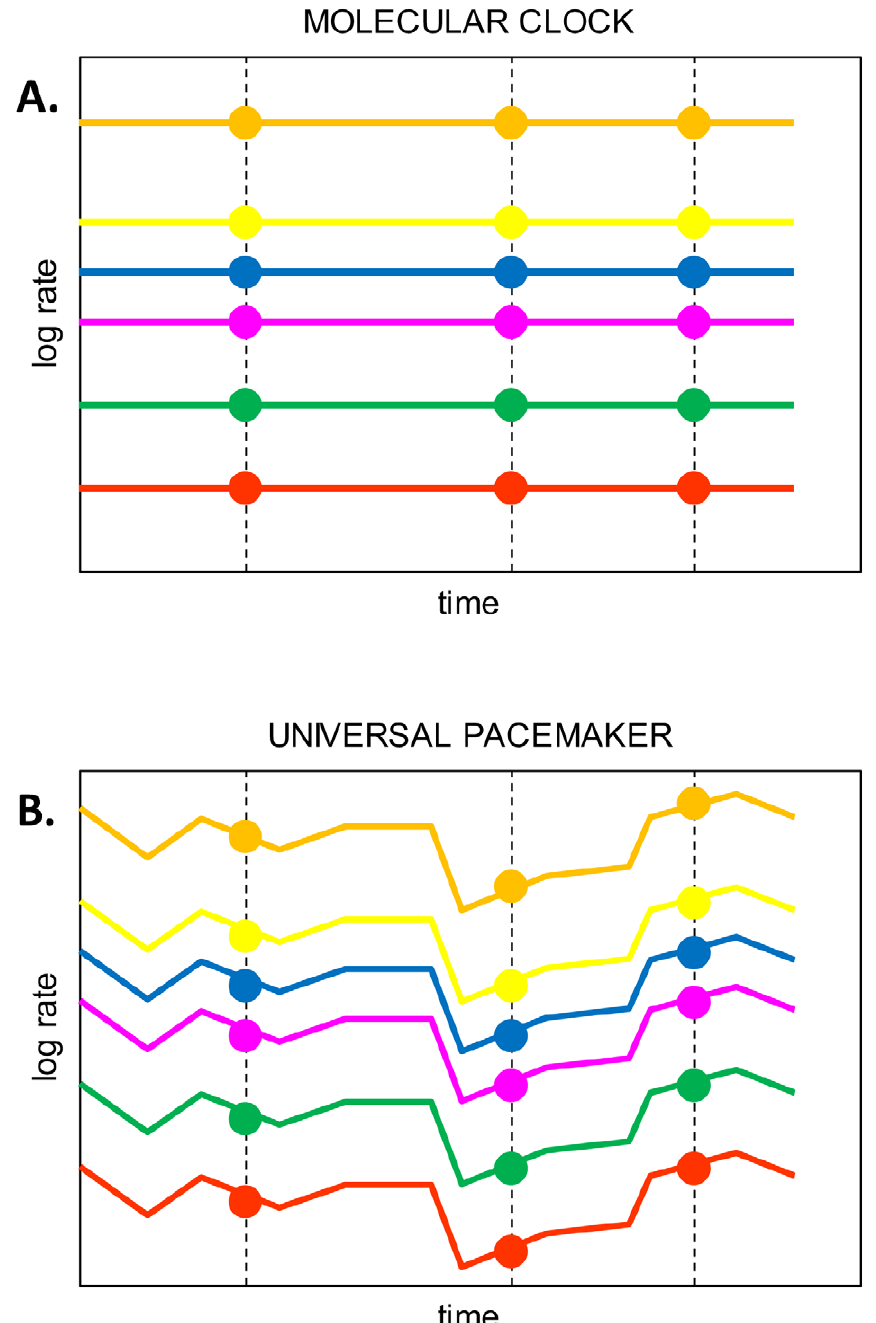
Figure 2. The Universal Molecular Clock and Universal Pacemaker models of genome evolution. A. Under the Molecular Clock model, gene-specific evolution rates (colored lines) remain constant; at any point in time (shown as dots), the relative rates of gene evolution are also constant. B. Under the Universal Pacemaker model, gene-specific evolution rates can change arbitrarily but by the same amount across the entire genome; at any point in time, the relative rates of gene evolution remain